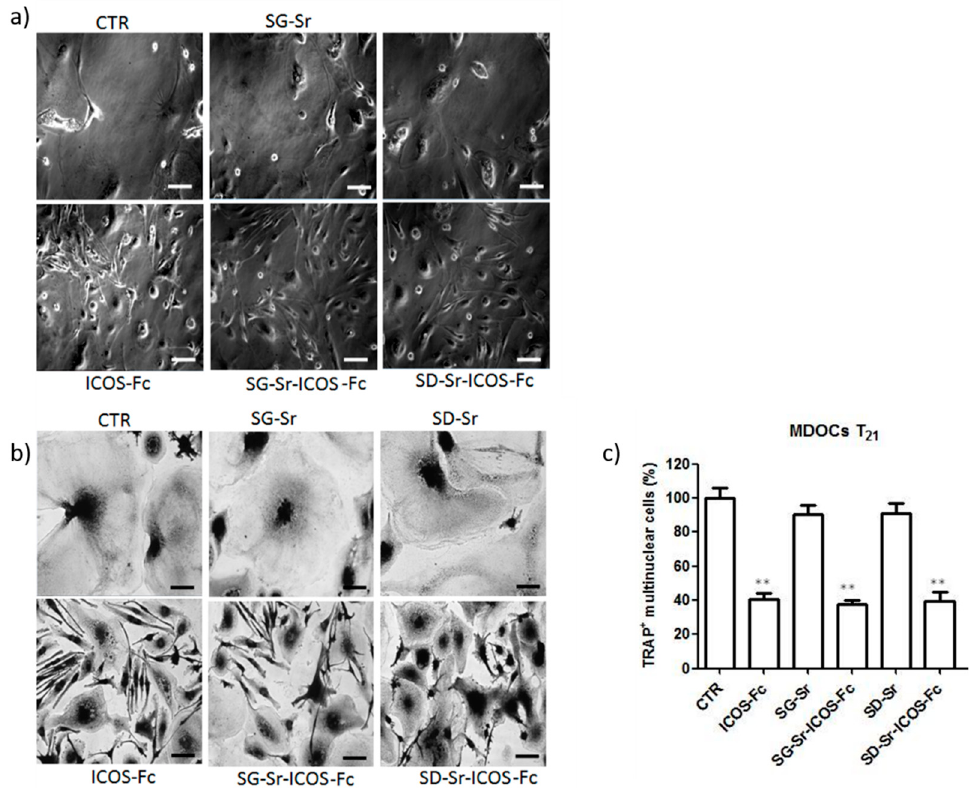
Figure 15. Effect of ICOS-grafted MBGs on MDOC differentiation using the T0–21 treatments. Monocytes were induced to differentiate to MDOCs in the presence and absence of SG-Sr-ICOS-Fc and SD-Sr-ICOS-Fc from day 0 (T0–21 treatment). ( a ) Phase-contrast microscopy of cells at T21 observed at X20 original magnification ( b ) Microphotographs of TRAP staining at T21 were observed at original magnification X20. ( c ) Bar graphs show the percentage of the multinuclear TRAP+ cells at T21. Data are expressed as the mean ± SEM of the percentage of inhibition versus the control (set at 100%) by counting 10 fields per sample (** p < 0.01 versus the control; Dunnett’s test). Scale bar 125 µm.